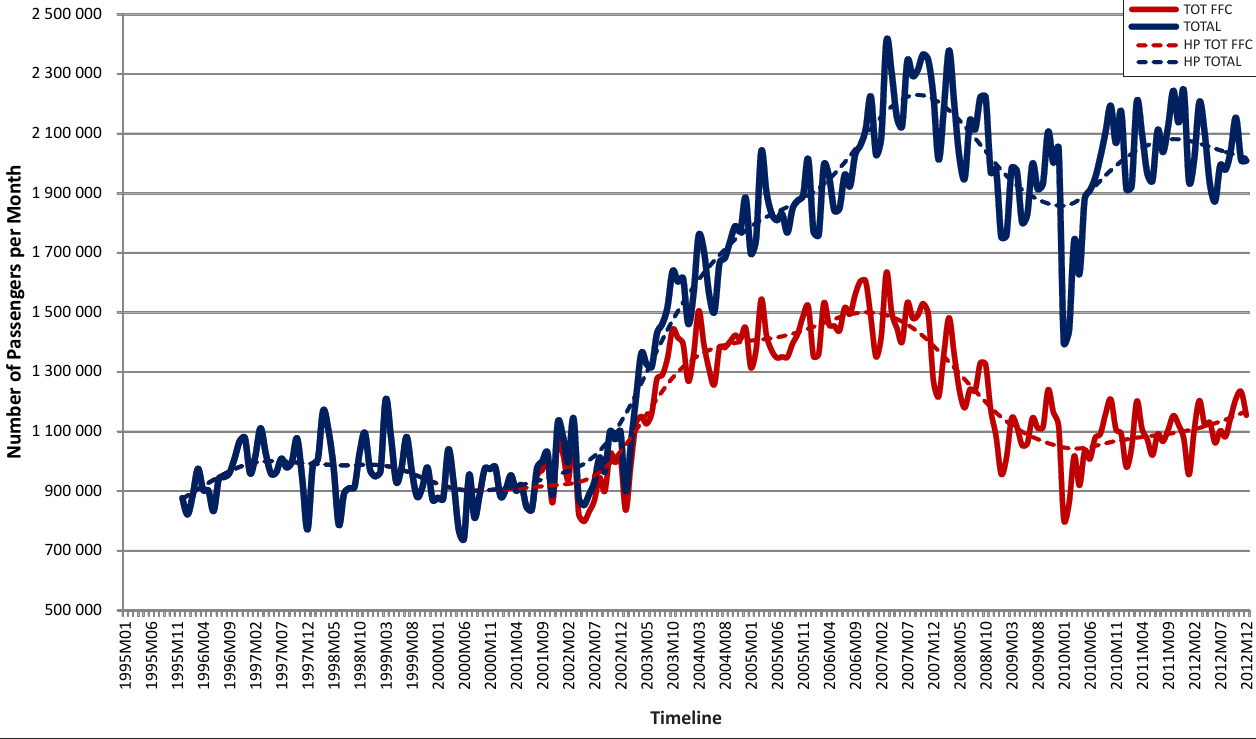
FIGURE 1: Passenger trends on the ‘Golden Triangle’ (total scheduled domestic arrivals and